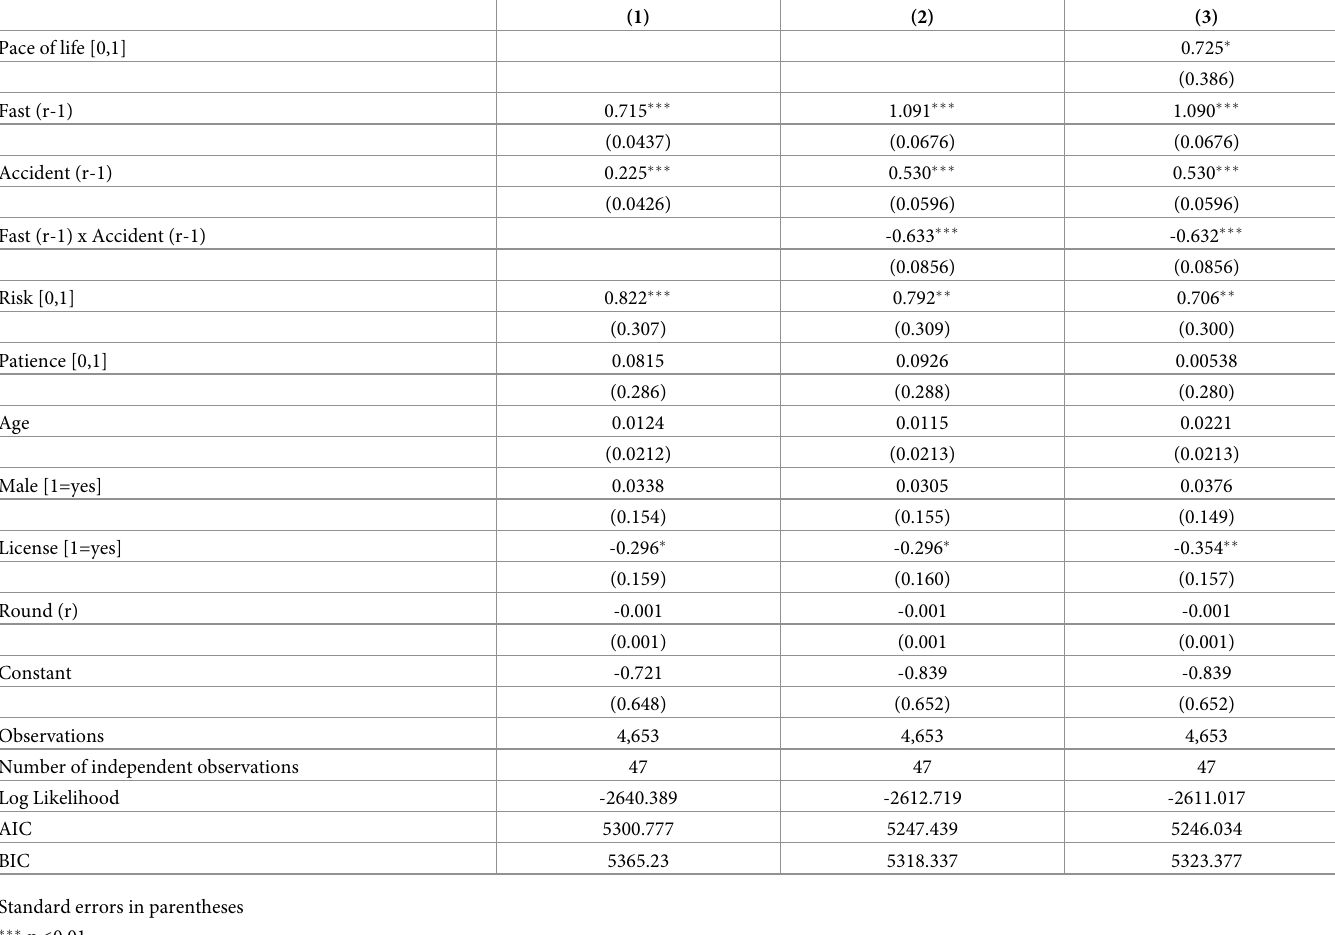
Table 4. Random-effects regression for choosing